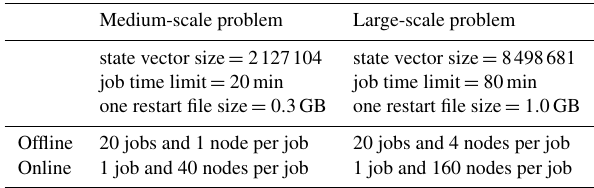
Table 1. Experiments for comparing the offline and online